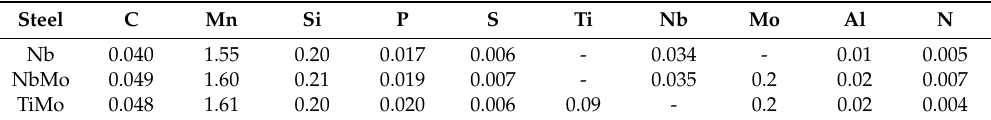
Table 1. Chemical composition of the steels (weight